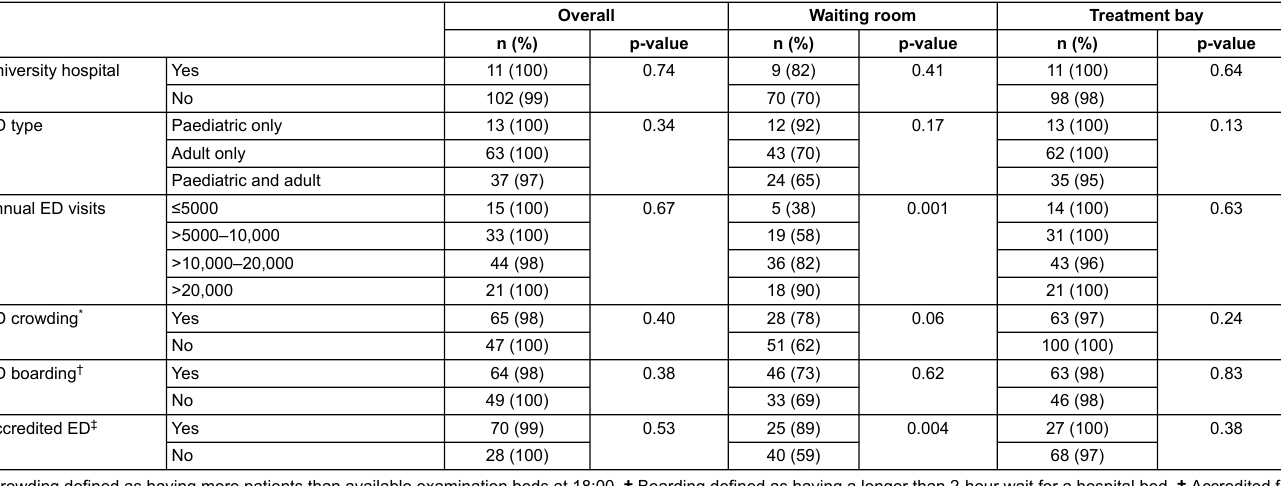
Table 1: Assessment of pain with a validated tool and emergency department (ED) characteristics.